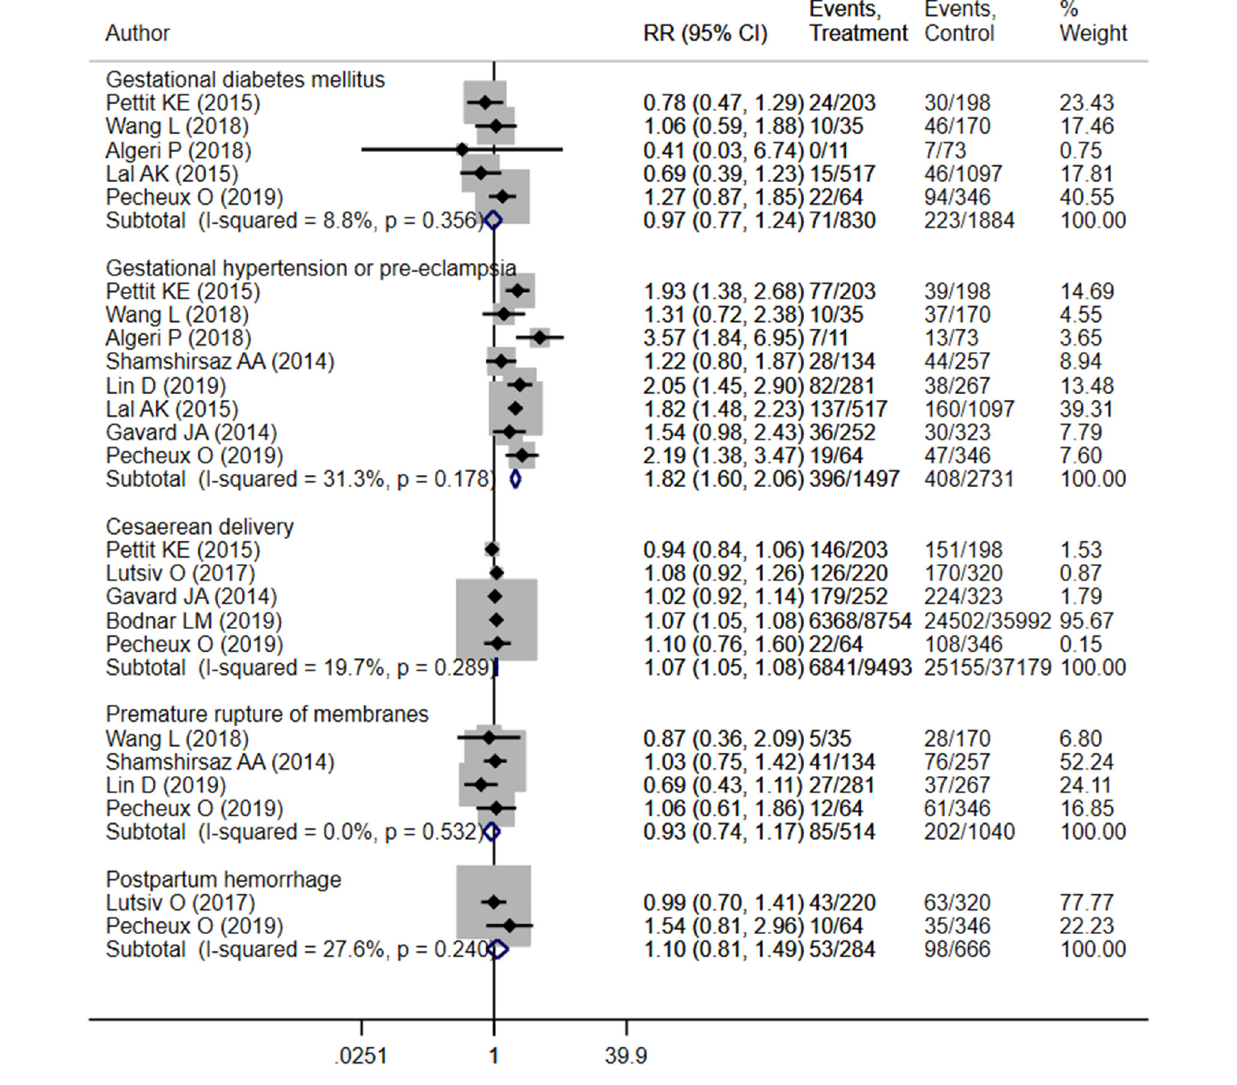
I 2 = 44.8%; N = 3) and very preterm status (OR 1.47;